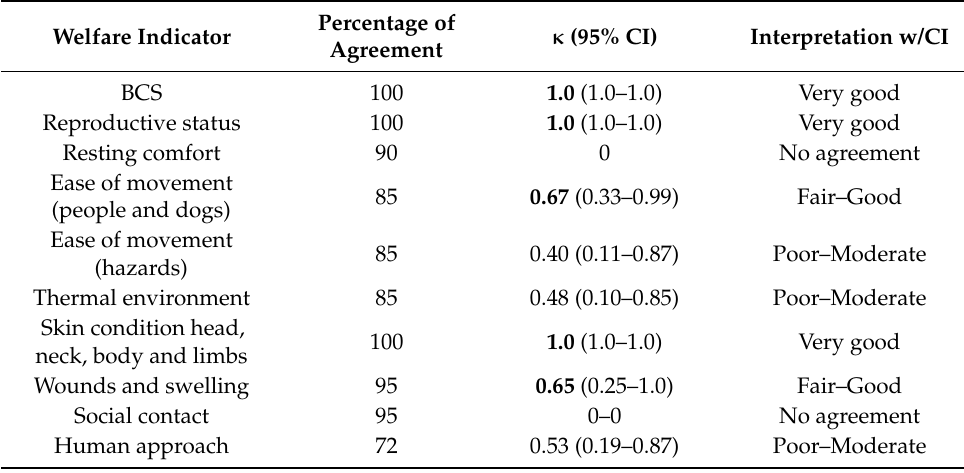
Table 5. Kappa estimates and their 95% confidence intervals for welfare indicators in the prototype assessment (test/retest reliability). All kappa values of 0.61 (good) and above are shown in bold. Interpretation is according to the work of Altman